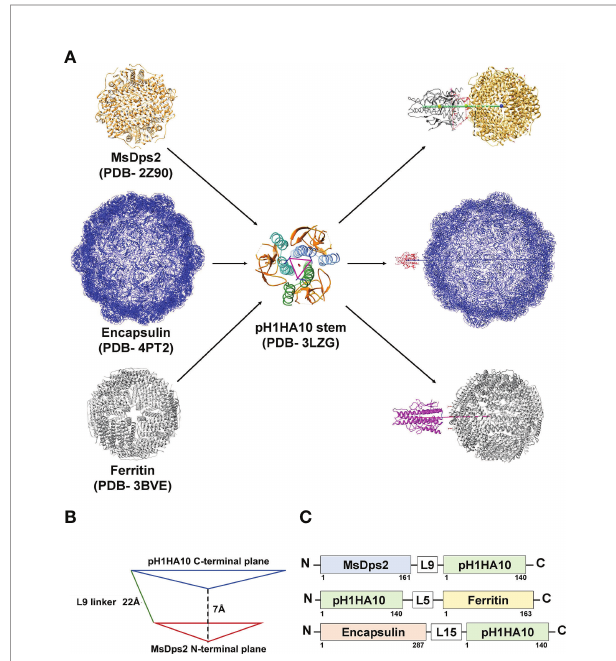
FIGURE 1 | Design of pH1HA10-nanoparticle fusion constructs. (A) Representative diagram showing stem immunogen, pH1HA10, displayed on the various sized nanoparticle platforms, MsDps2 (PDB id. 2Z90) Encapsulin (PDB id. 4PT2) and Ferritin (PDB id. 3BVE). All nanoparticle representations were generated in UCSF Chimera using their respective PDB coordinates. (B) Schematics of construct design for MsDps2-pH1HA10. The coaxially aligned planes containing the C and N terminal, respectively, of MsDps2 and pH1HA10 are separated by 7Å to avoid steric hindrance. The distance between the N terminal Asp 1 of pH1HA10 and C terminal Val 161 of MsDps2 is 21Å, which is spanned by a 9-residue long linker. The same design was extended to Encapsulin and Ferritin- stem fusion constructs. (C) MsDps2 and Encapsulin are linked to the N terminus of pH1HA10 through 9-residue and 15-residue long linkers (L9 and L15) respectively, whereas Ferritin is fused at the C terminus of pH1HA10 through a 5-residue long linker